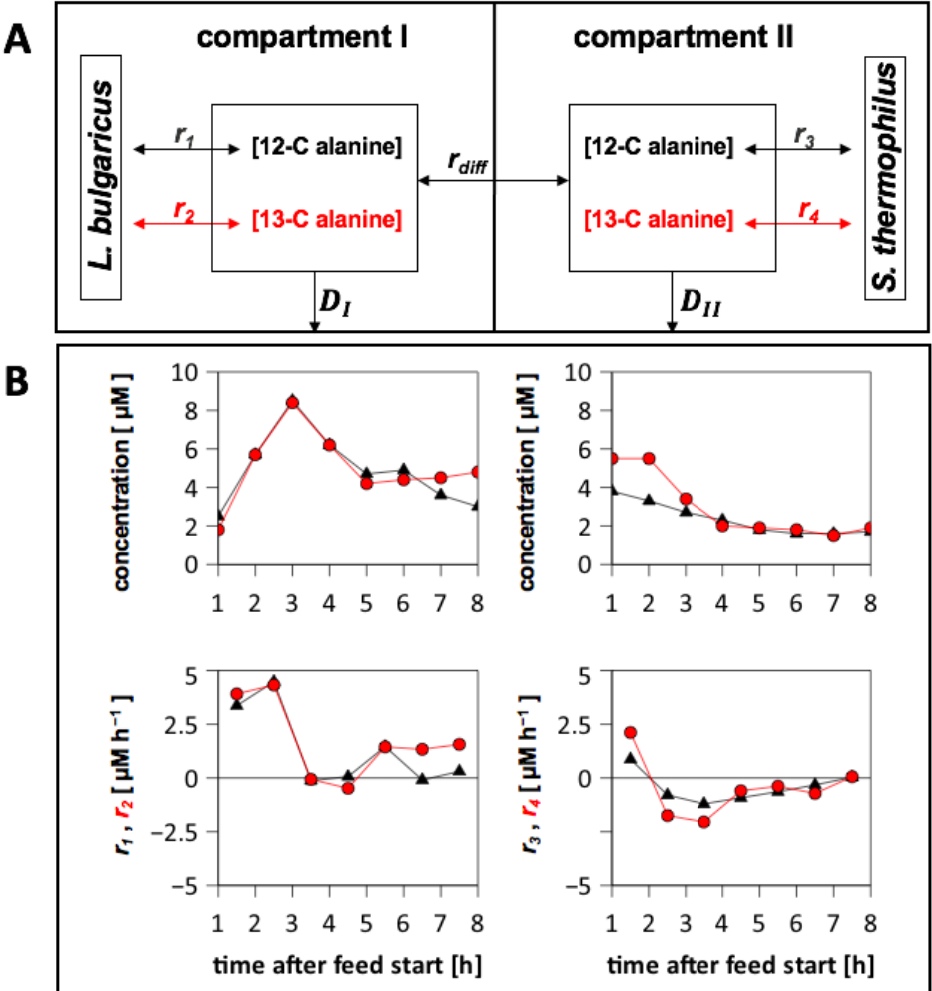
Figure 6. Alanine production and consumption of Streptococcus thermophilus and Lactobacillus del- brueckii subs. bulgaricus cultivated in the tube bioreactor system. ( A ) Illustration of alanine pools in the tube bioreactor system. r 1 and r 3 are the production and consumption rates of non-labelled ala- nine; r 2 and r 4 are the production and consumption rates of 13-C alanine; r diff is the diffusion rate of alanine in the membrane unit according to concentration differences; and D is the dilution rate in compartment 1 or compartment 2. ( B ) Compartment 1 was filled with L. bulgaricus and synthetic medium (SM) with casein and 13-C glucose. Compartment 2 was filled with S. thermophilus and SM with 13-C glucose. Concentrations of non-labelled ( triangle ) and 13-C alanine ( circle ) were measured via LC-MS. Strain-specific rates were calculated by balancing each compartment. Positive rates: production; negative rates: consumption.